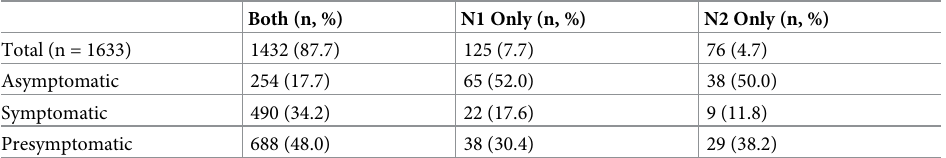
Table 4. Amplification of one vs. both targets.